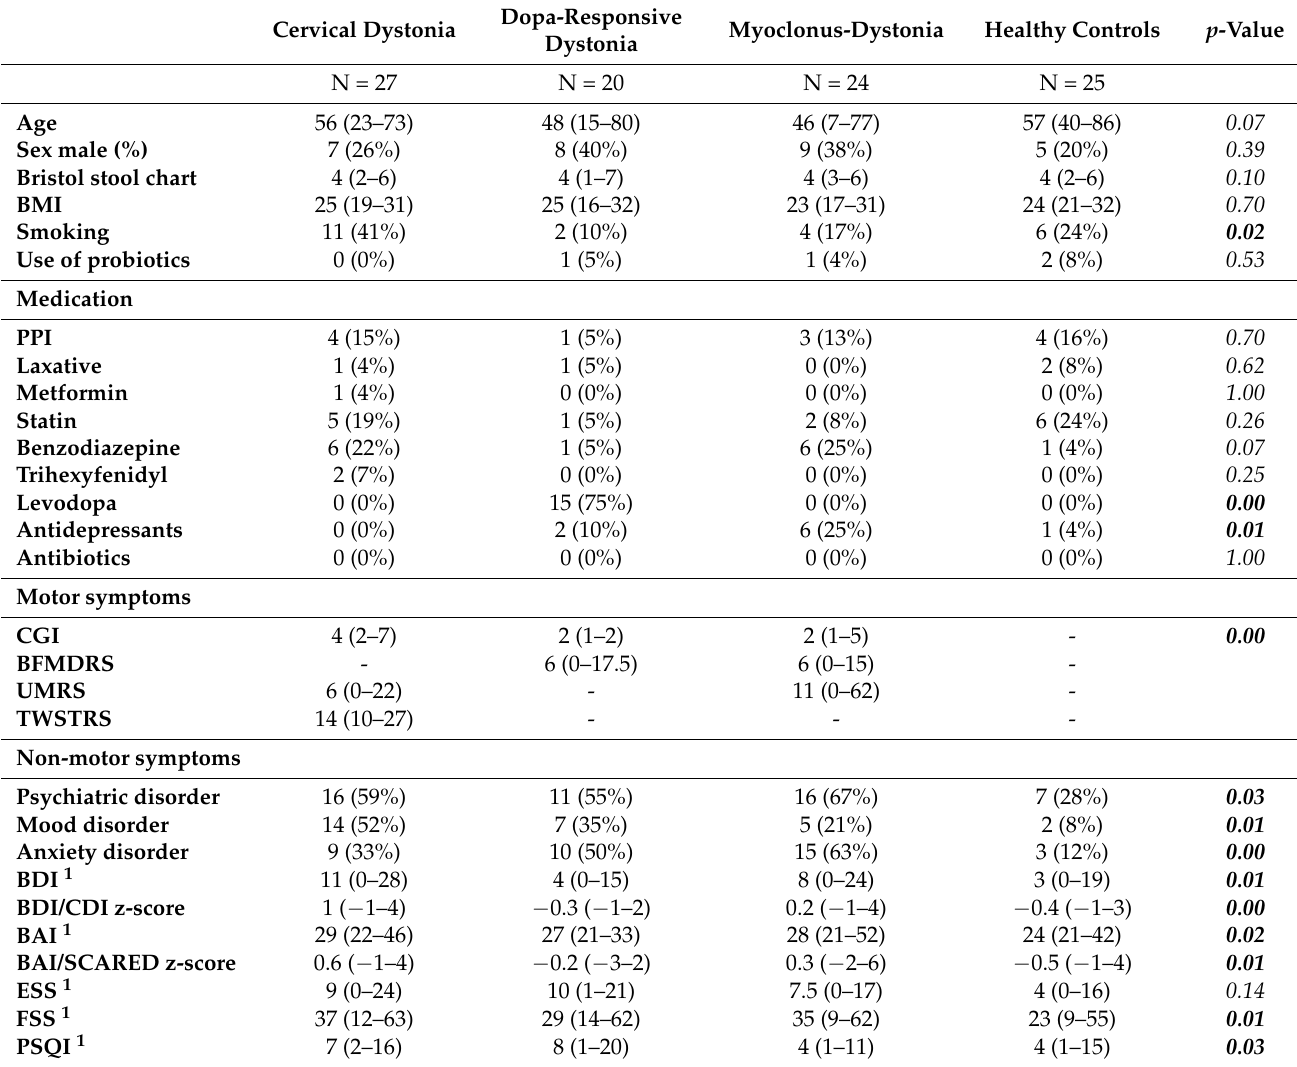
Table 1. Demographic and clinical characteristics of